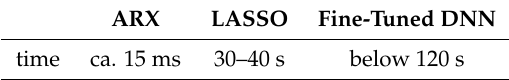
Table 3. Approximate times needed to generate one day of the forecasts using different methods. Note the differences in the units. The time listed for the DNN is a worst-case scenario, see the description in the